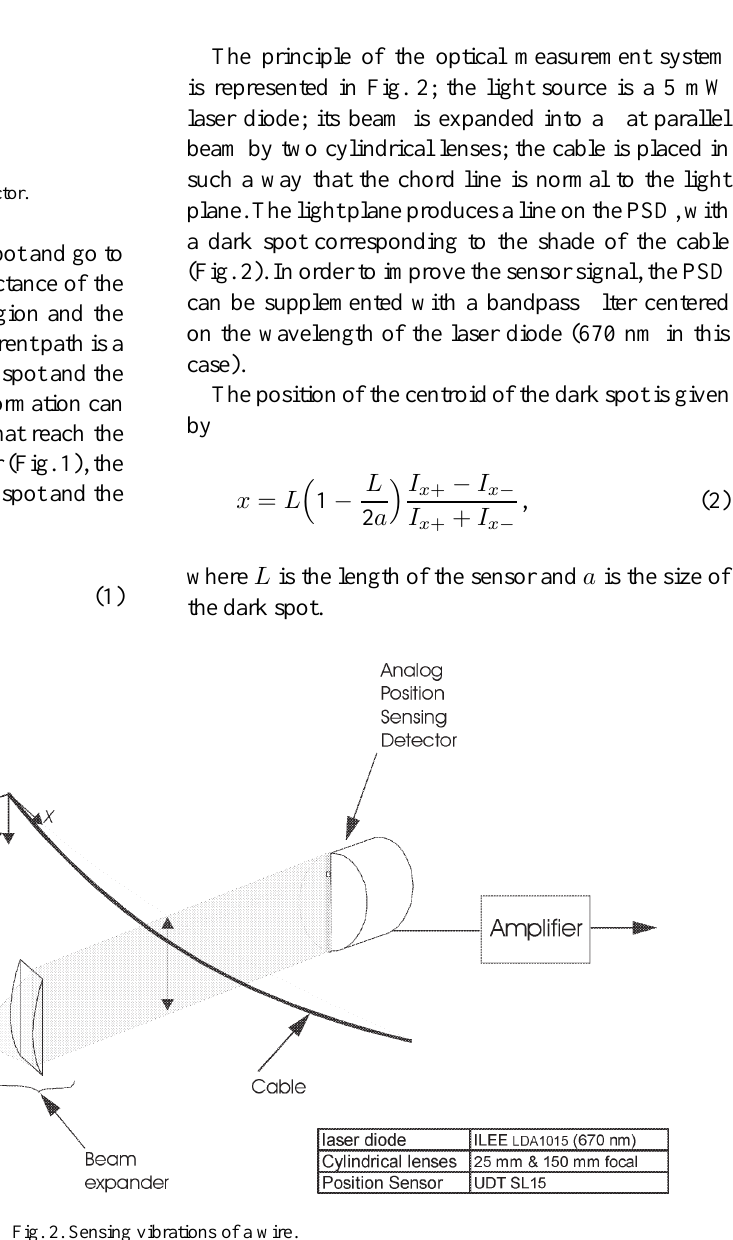
Fig. 2. Sensing vibrations of a